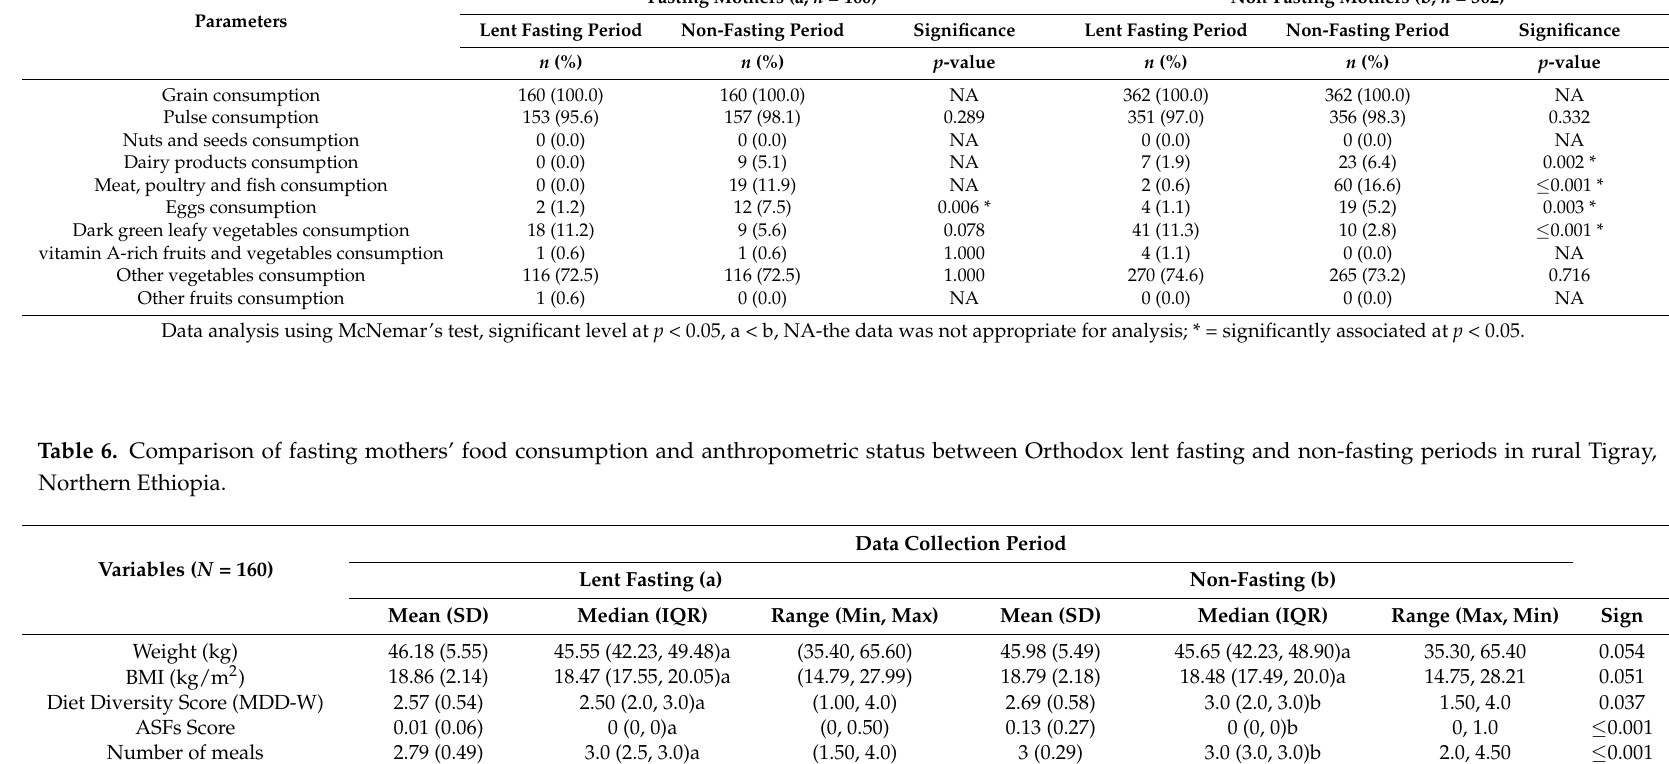
Diet Diversity Score